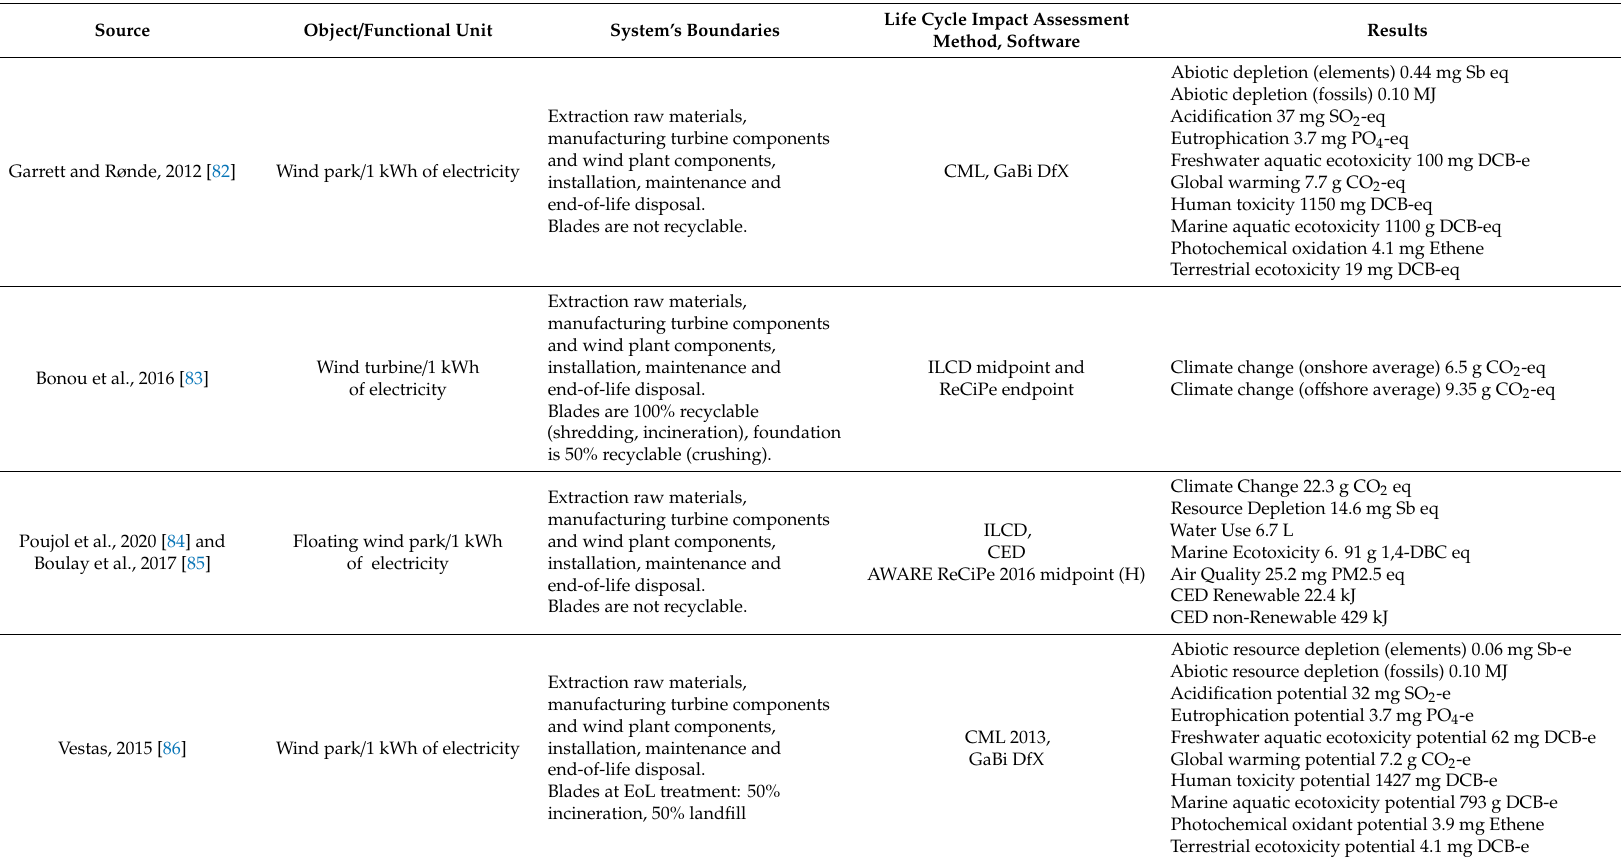
Table 5. LCA data for wind turbines and